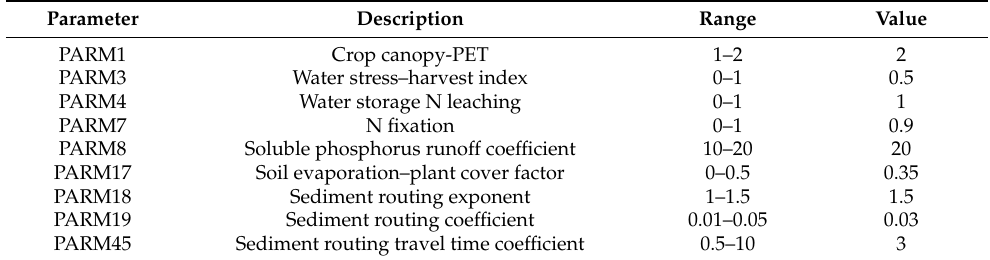
Table 6. Key APEX model parameters resulting from calibration/validation process.